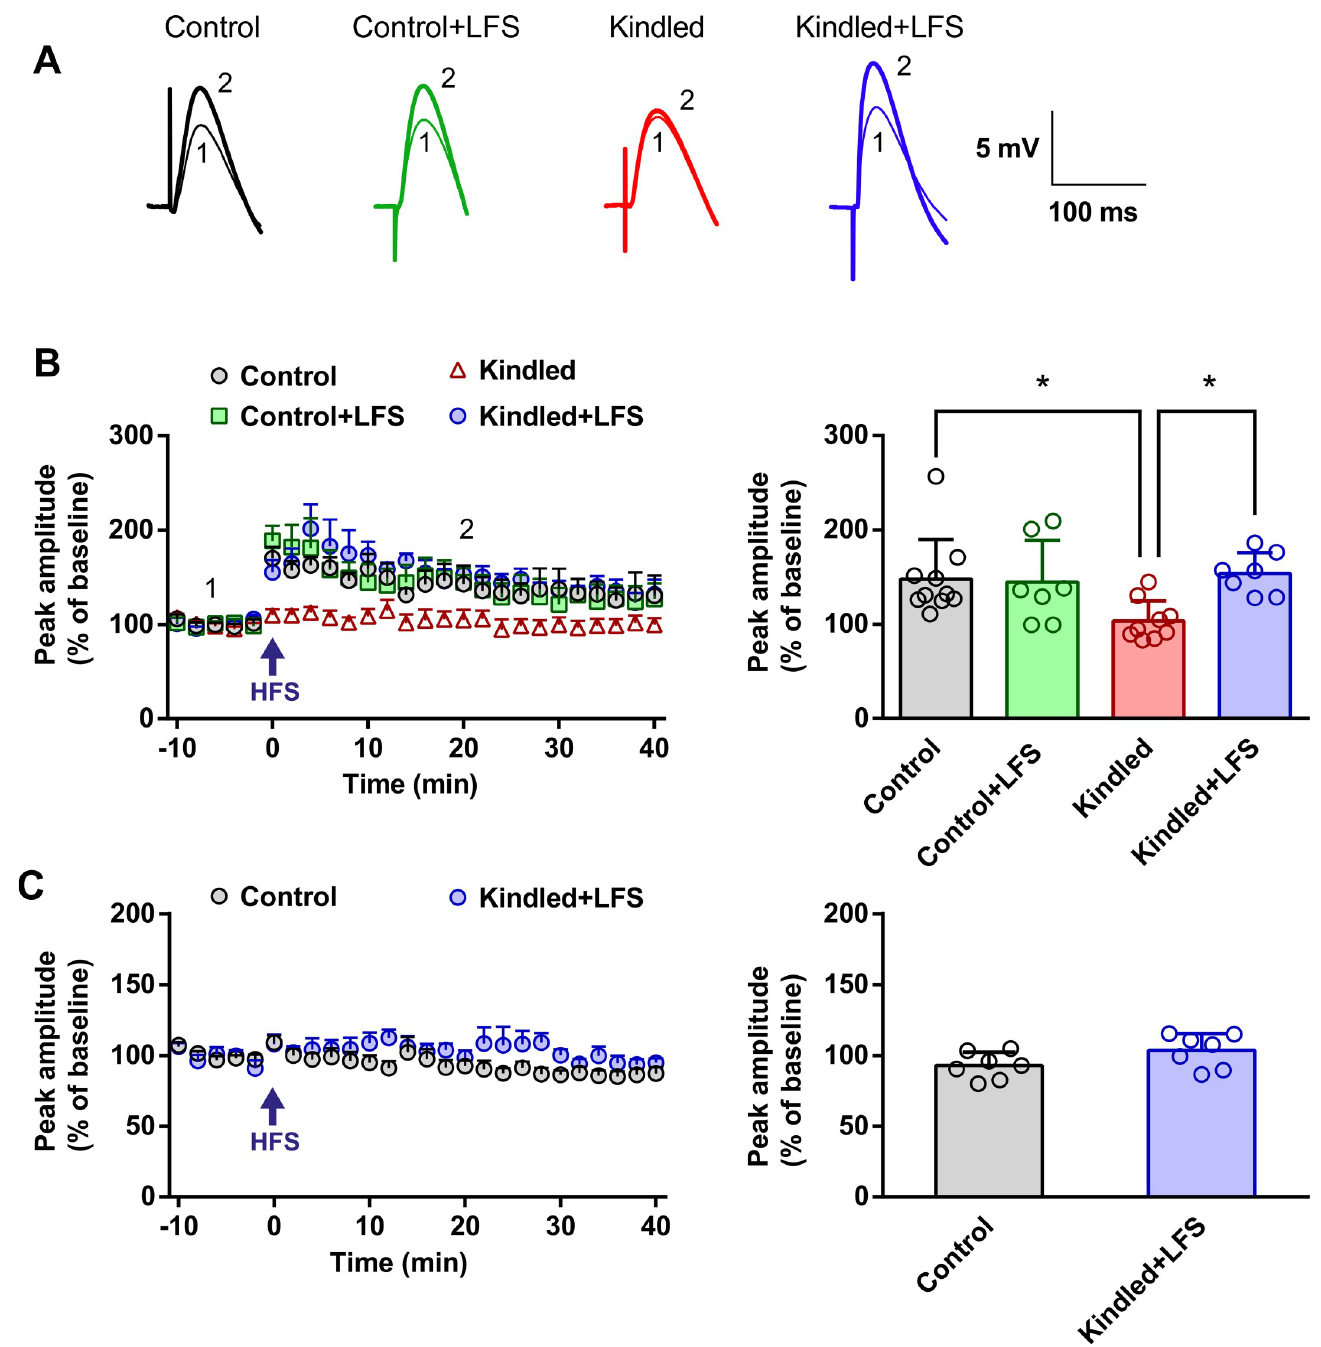
Fig 3. Improvement of iLTP induction in hippocampal slices of kindled animals, following LFS application. (A) IPSPs sample recordings in different experimental groups, before (1) and after (2) HFS application. The numerals near the traces correspond to the times indicated by the same numerals in the graphs. (B) Left: Time course of the IPSP amplitude alteration (% of the baseline) within 40 min after HFS delivery. In the kindled group, iLTP was attenuated significantly compared to the control group. This impairment in iLTP induction was restored following application of LFS in kindled animals. Delivery of LFS alone in control animals did not affect the magnitude of iLTP induction. Right: The bar graph shows the quantitative analysis of iLTP. Control: n = 11, Control+LFS: n = 7, Kindled: n = 9, Kindled+LFS: n = 7. (C) Investigating the role of Ca2+ in iLTP induction in the control and kindled+LFS groups. Left: Time course and Right: bar graph represent that HFS could not induce iLTP in both of control and kindled+LFS groups in the presence of BAPTA (a Ca2+ chelator). Control: n = 7, Kindled+LFS: n = 7. Data are shown as mean ± SEM. � p < 0.05 compared to control group.